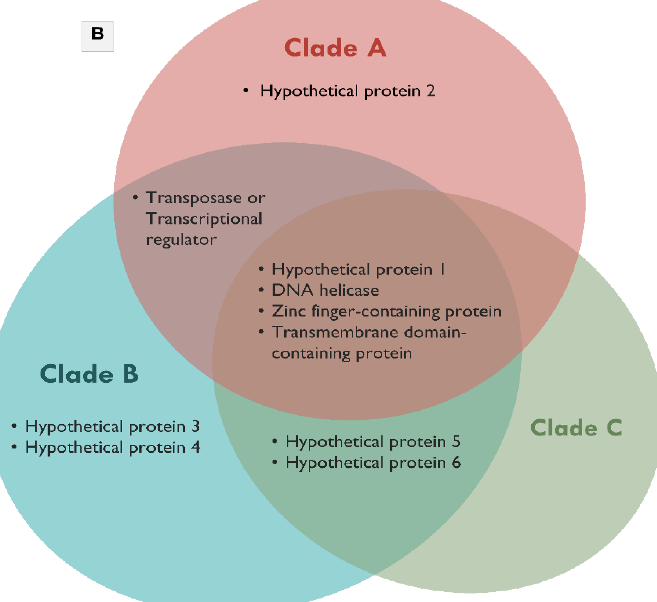
Figure 5. Genomic comparison between known transpoviron sequences. ( A ) Individual maps of the seven known transpovirons. Colored arrows indicate the ORFs distribution throughout genomes. Homolog ORFs are represented by the same color, and each predicted function is indicated in the color legend. Right-directed arrows represent positive strand ORFs and left-directed arrows represent negative strand ORFs. ( B ) Venn diagram summarizing the transpovirons proteins occurrence in each of the three clades (A, B and C). Note: megavirus courdo7 transpoviron is described to encode six ORFs; however, only five were found in the NCBI database. The transpoviron sequences were obtained through the following GenBank accession numbers: JQ063128.1 (mamavirus transpoviron);